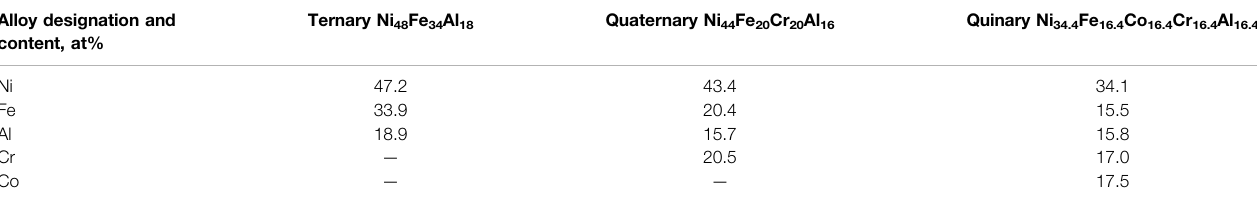
TABLE 1 | Alloy designation and composition of the samples as measured by energy dispersive spectroscopy. Alloy designation and content,